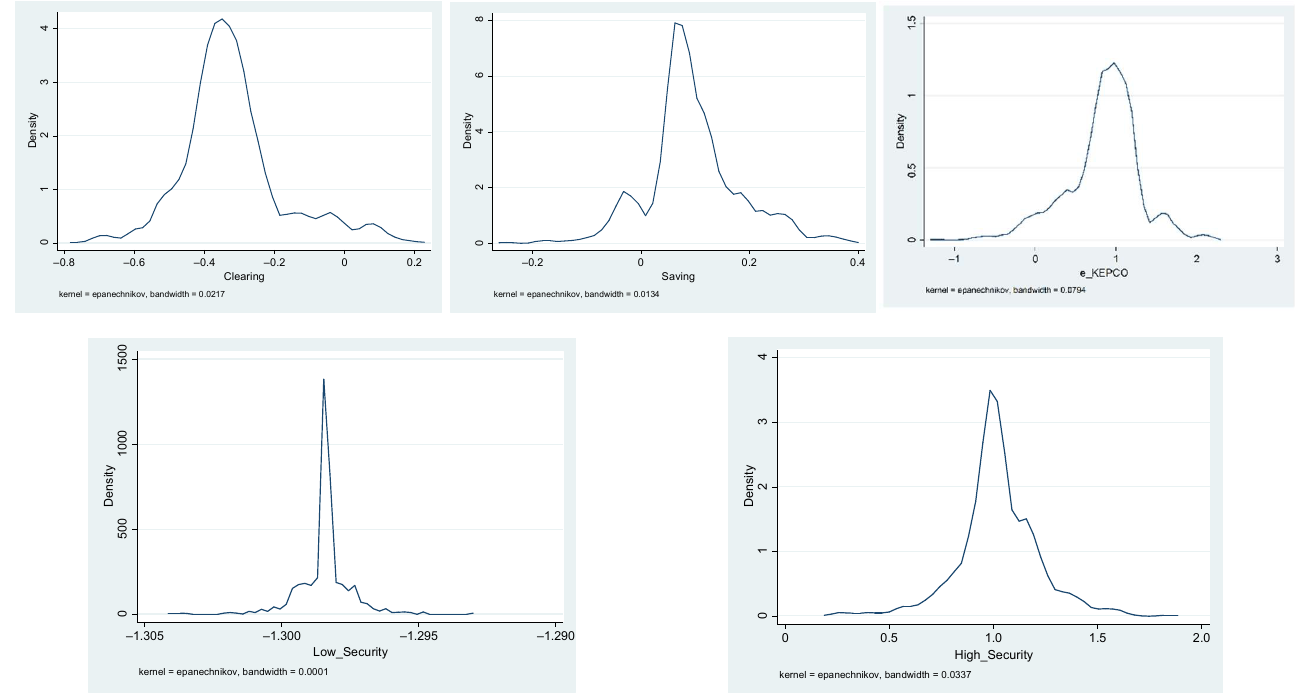
Figure 5. Kernel Density Plots for Attributes of the Hybrid Model (Class IV).